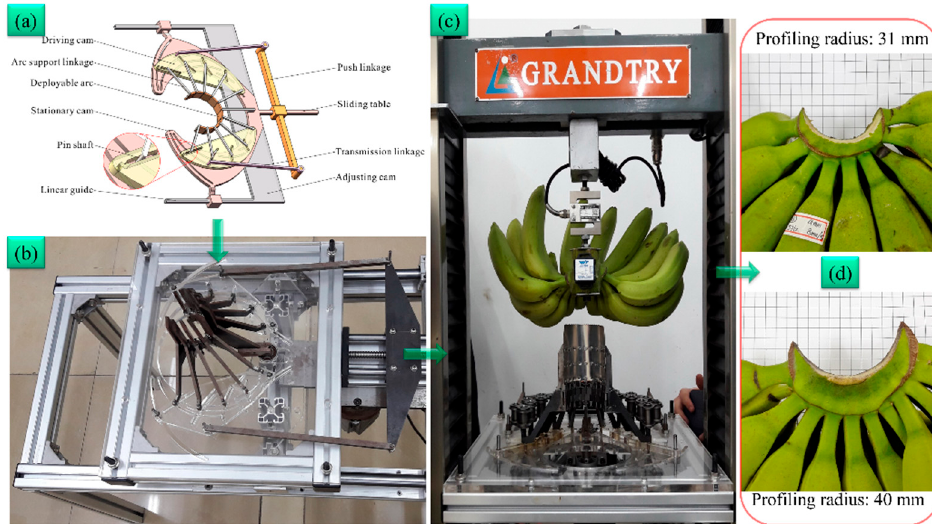
Figure 6. Design and application of the circumferentially expandable de ‐ handing platform. ( a ) Schematic diagram of the profiling mechanism, ( b ) Prototype of the de ‐ handing platform, ( c ) Schematic of an indoor experiment, ( d ) Incision of banana hands with different profiling radius.